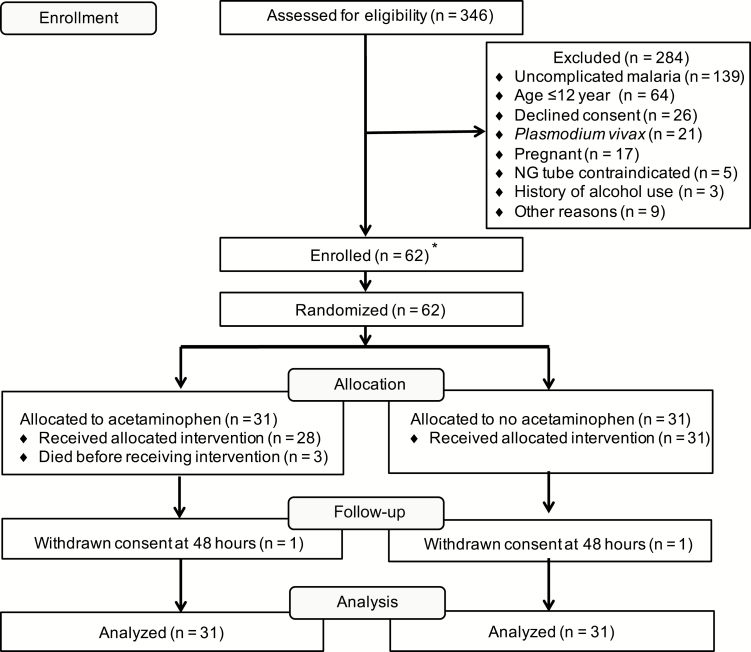
Flow chart for the “Acetaminophen as a Renoprotective Adjunctive Treatment in Patients With Severe and Moderately Severe Falciparum Malaria” study. *A total of 30 patients were recruited in Chittagong, Bangladesh, and 32 patients were recruited in Ramu, Bangladesh. Abbreviation: NG, nasogastric.